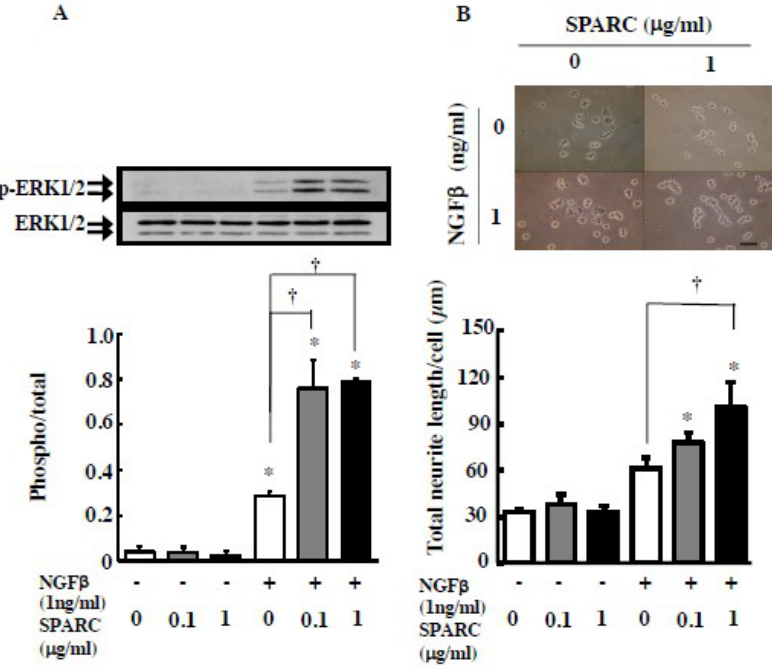
Table 2. Summary of analyte binding to